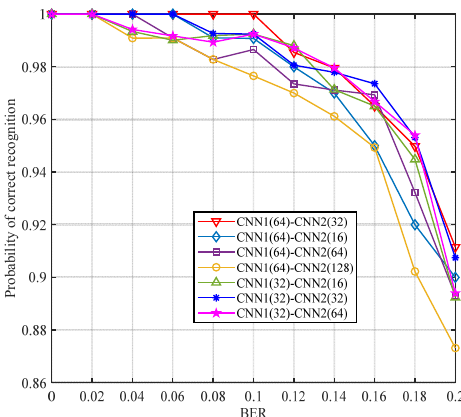
Figure 10. The effect of the number of cells of LSTM on the performance of the algorithm.